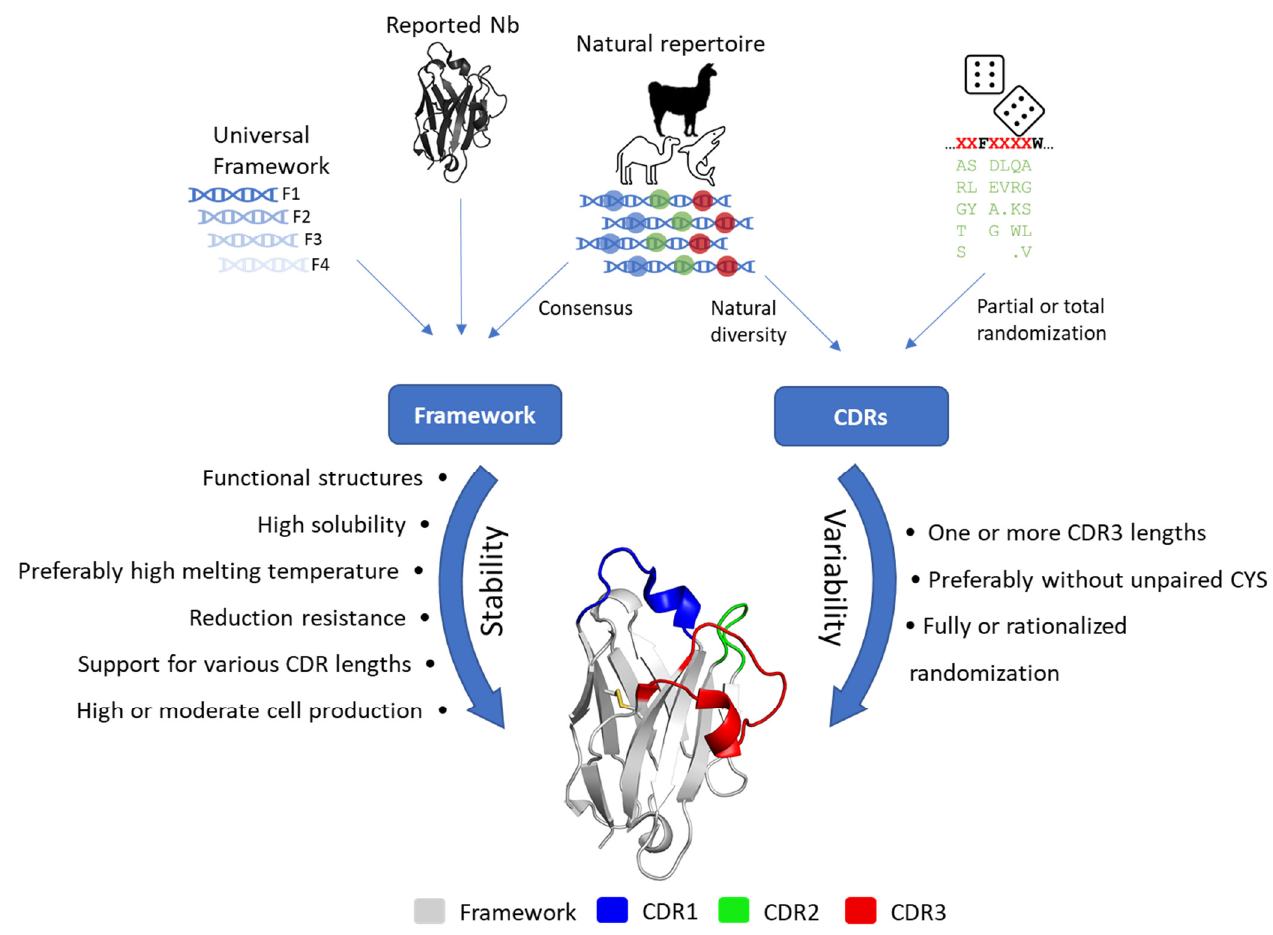
Figure 2. Strategy and desired physicochemical characteristics for the generation of synthetic libraries. The design and construction of a synthetic library comprise two main factors: the framework and the CDRs. A previously reported universal or Nb-derived framework can be used for a new library. Alternatively, a new framework can be generated from a consensus sequence derived from natural repertoires. Similarly, the design of CDRs can be carried out in a rationalized way, considering the natural diversity in natural repertoires, or be generated in a partially or completely randomized way. While framework selection is more focused on stability, CDR design focuses more on variability. In both cases, the listed characteristics should be considered to obtain a robust and functional synthetic